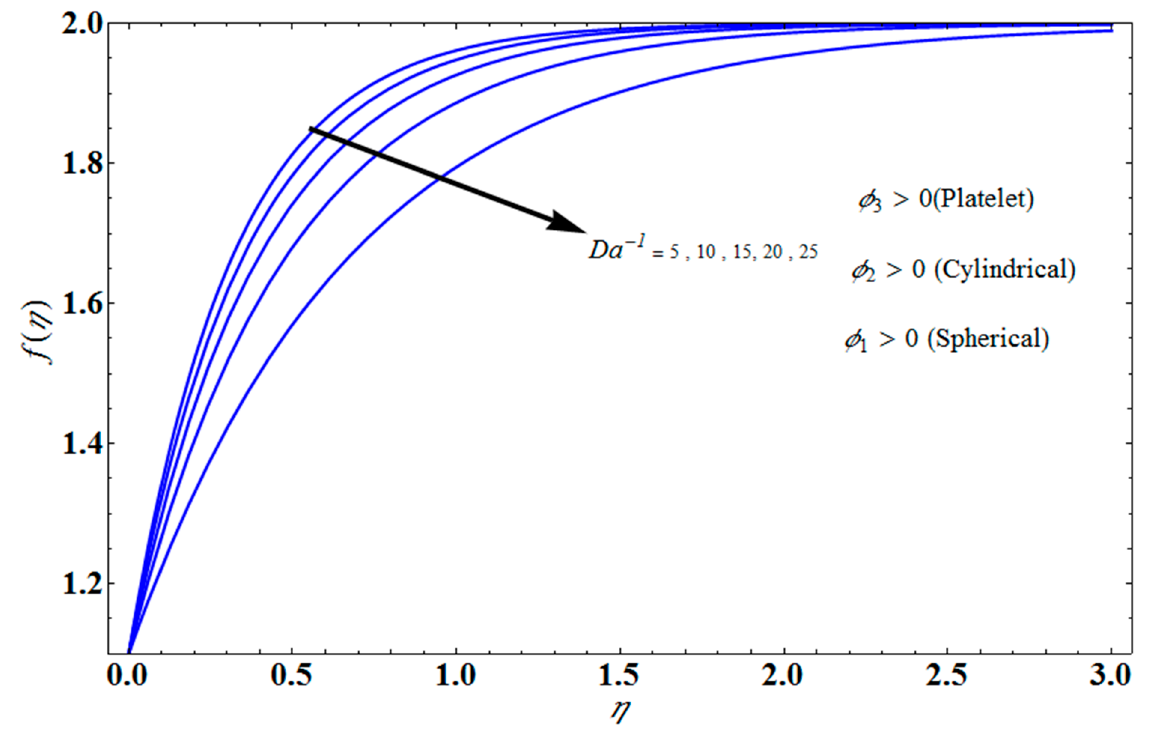
( ) ( ) f η on η for several values of 1 Da − . f η on η for several values of 1 Da − . Figure 6. Effect of f ( η ) on η for several values of Da − 1 . Figure 6. Effect of Figure 6. Effect of